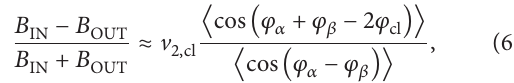
Figure 7: Three-point correlator as a function of centrality for Au+Au collisions at 7.7–200 GeV [48] and for Pb+Pb collisions at 2.76 TeV [49]. Note that the vertical scales are different for different rows. The systematic errors (gray bars) bear the same meaning as in Figure 6. Charge-independent results from the model calculations of MEVSIM [50] are shown as gray